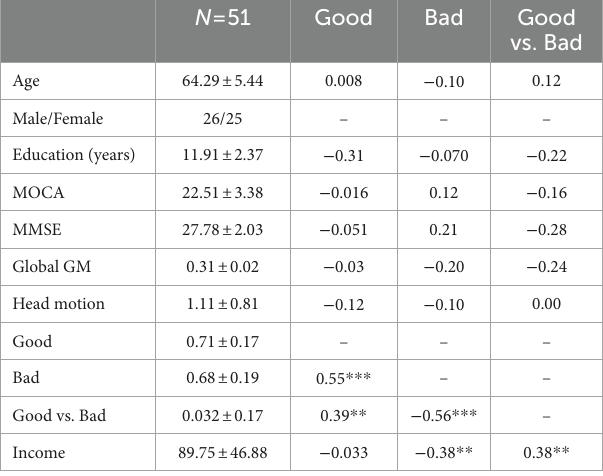
TABLE 1 Demographic, neuropsychological assessments and IGT